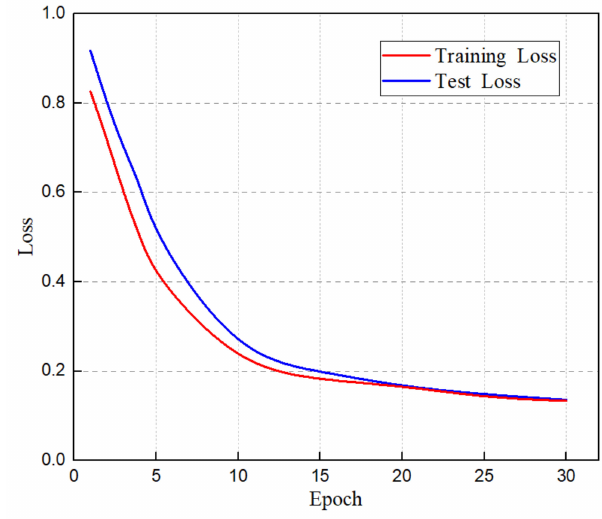
Figure 18. Loss curves for the training and testing of the InSARNet